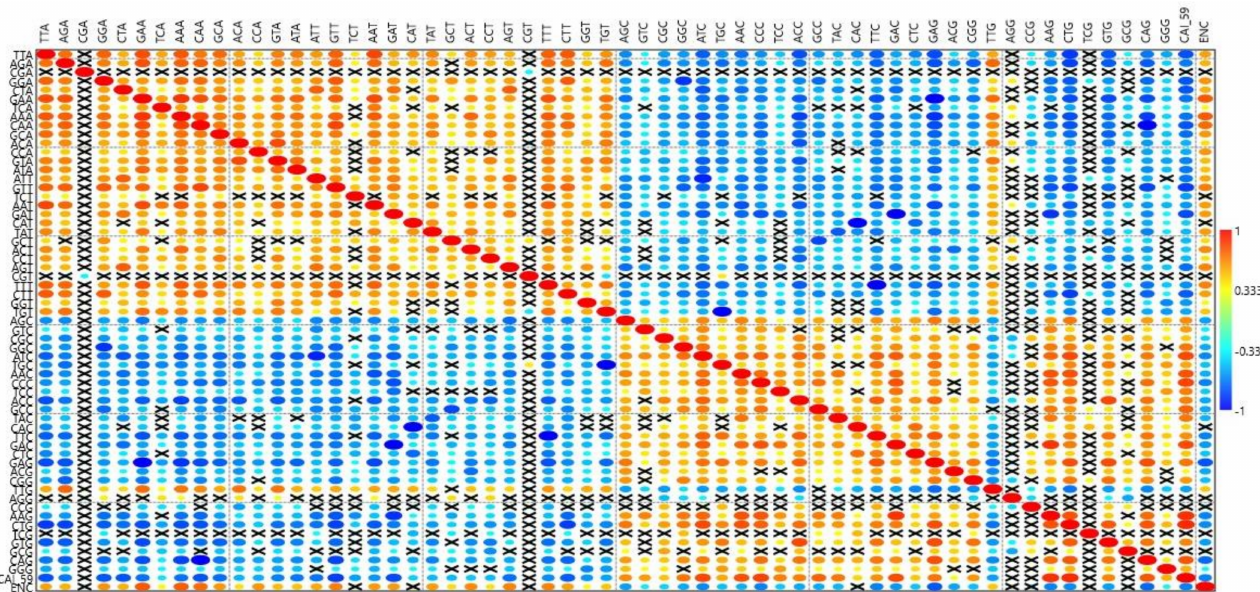
Figure 7. Mirror image plot depicting the correlation between RSCU values with gene expression and CUB. A bigger-sized eclipse described a higher Pearson’s correlation coefficient (r) value, and vice versa. The red colored circles show a positive correlation, whilst blue circles indicate a negative correlation. Crossed boxes show an insignificant correlation.